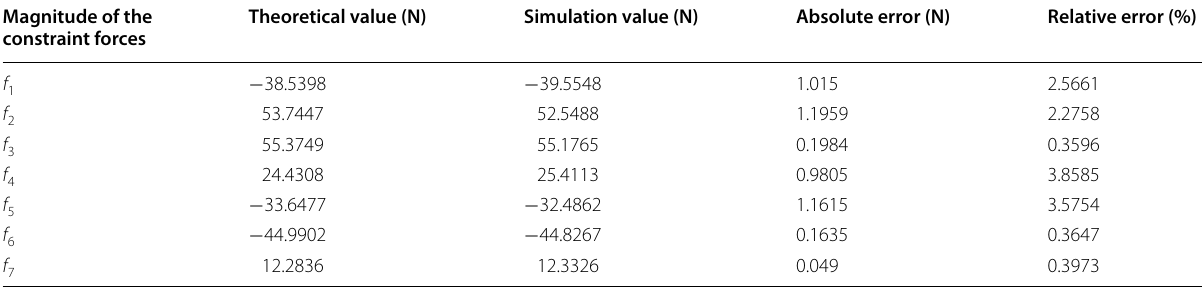
Table 2 Comparison between theoretical and simulation values of constraint forces Magnitude of the constraint forces